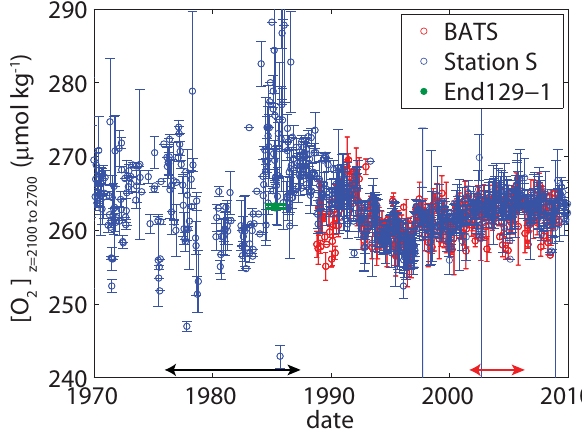
Fig. 8. Deep O 2 concentrations (mean of z = 2100 to 2700m) from BATS (blue) and Station S (red). Note the scattered and high O 2 val- ues in Station S data before 1992, especially in the period between 1985 and 1988. The black and red arrows represent the time-periods of the “old” and “new” AOUR data compared in the text. For com- parison, deep O 2 concentration (mean of z = 2100 to 2700) from station 50 on the Endeavor 129-1 leg is presented (green), a station that was close to the BATS site and thus presumably should have similar deep oxygen